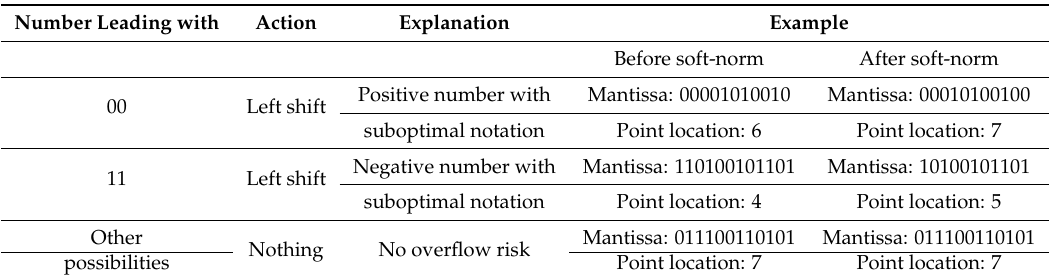
Table 2. Soft normalization rules for